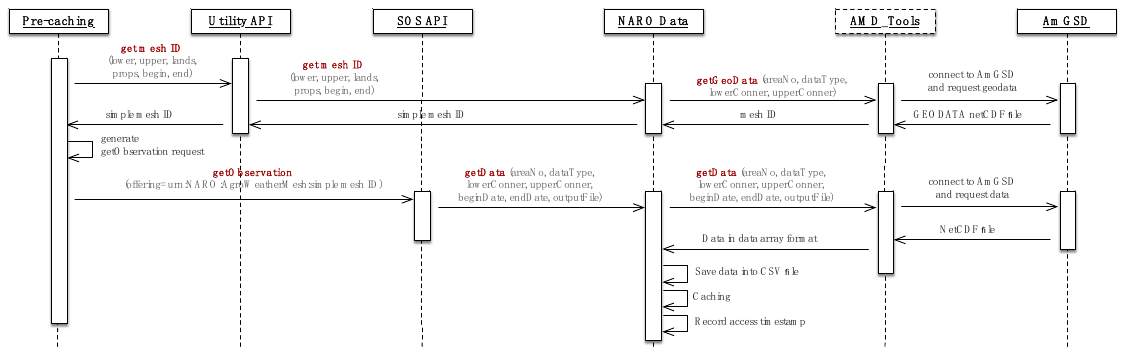
Figure 4. The sequence diagram represents the pre ‐ caching process.